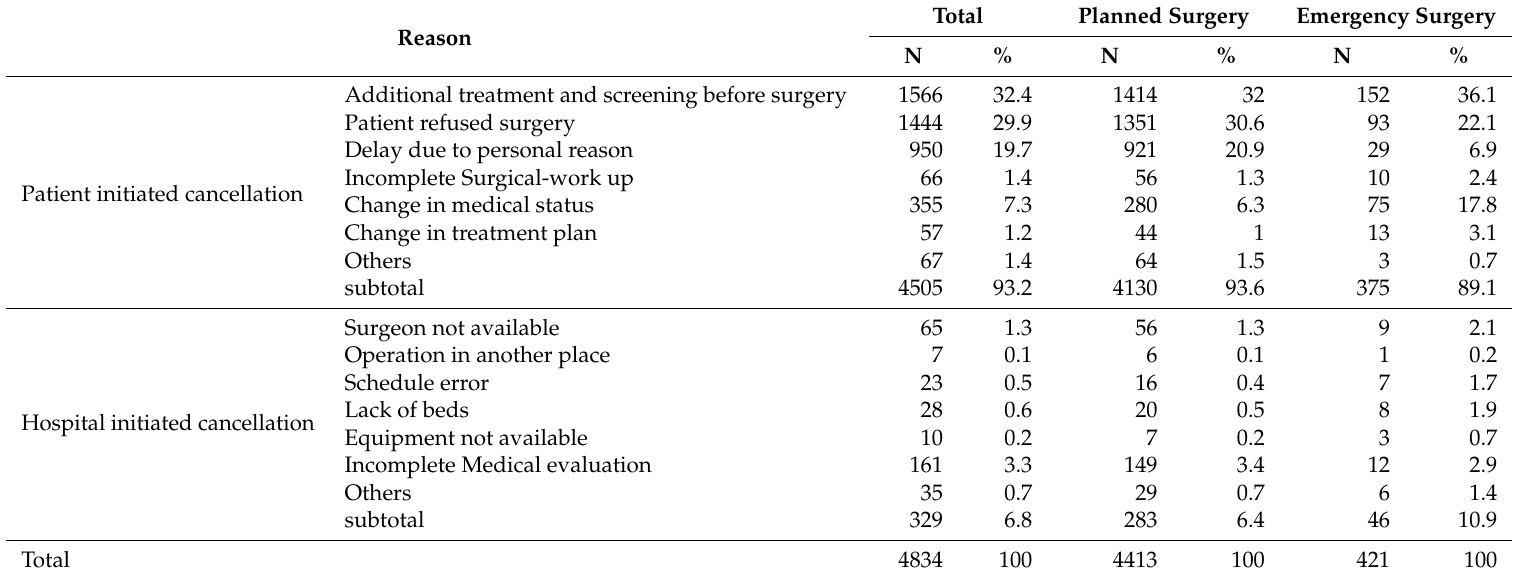
Table 2. The reasons for surgery